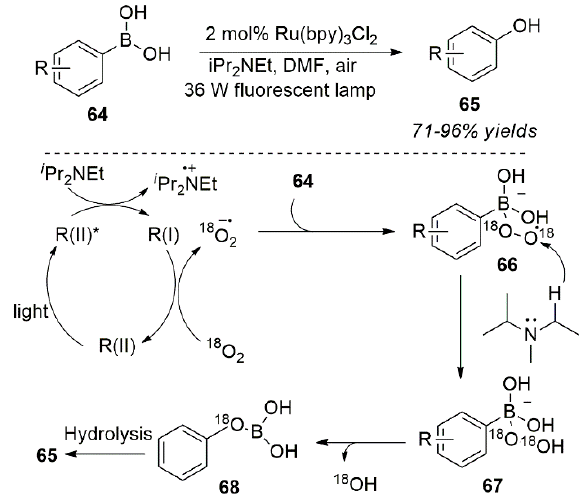
Scheme 28. Photo-oxidation reaction for a C-B bond cleavage.